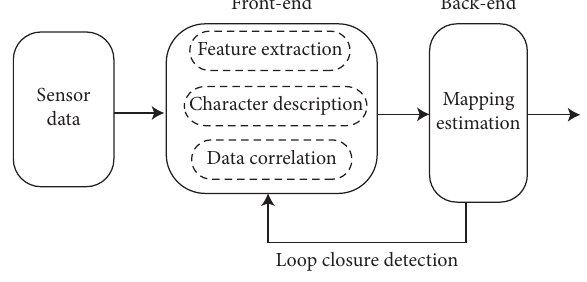
Figure 3: V-SLAM fow